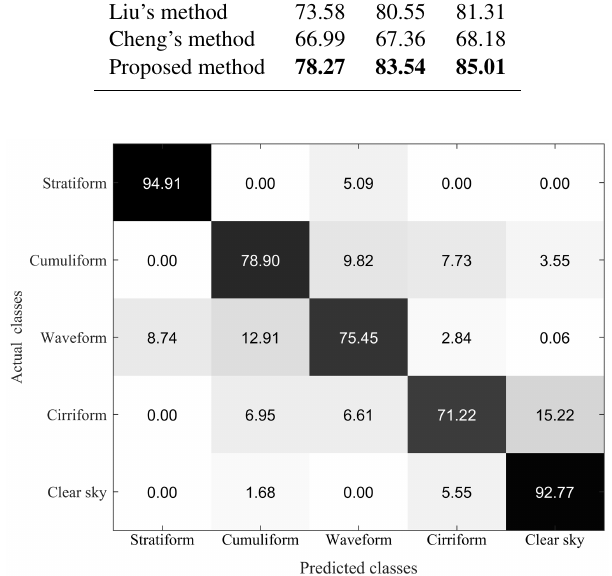
Figure 8. Confusion matrix (%) on the whole-sky dataset. (1 / 2 for training and the overall accuracy is